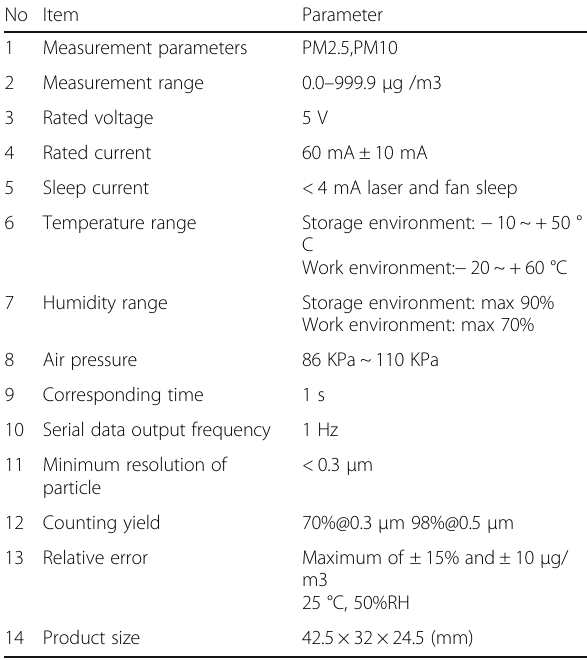
Table 1 Specification of Pocket PM 2.5 Sensor (Yaguchi Electric